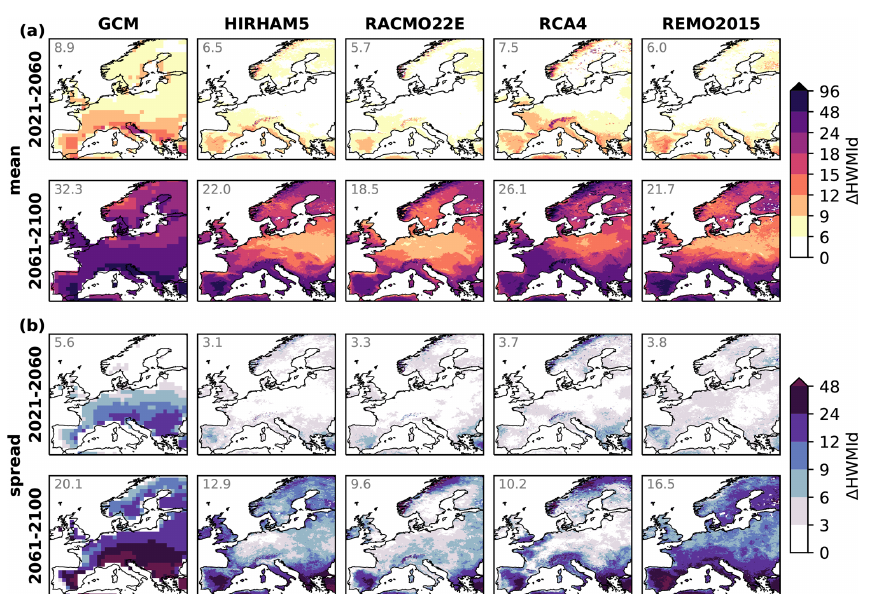
Figure 7. As Fig. 4 but for the climate change in HWMId.